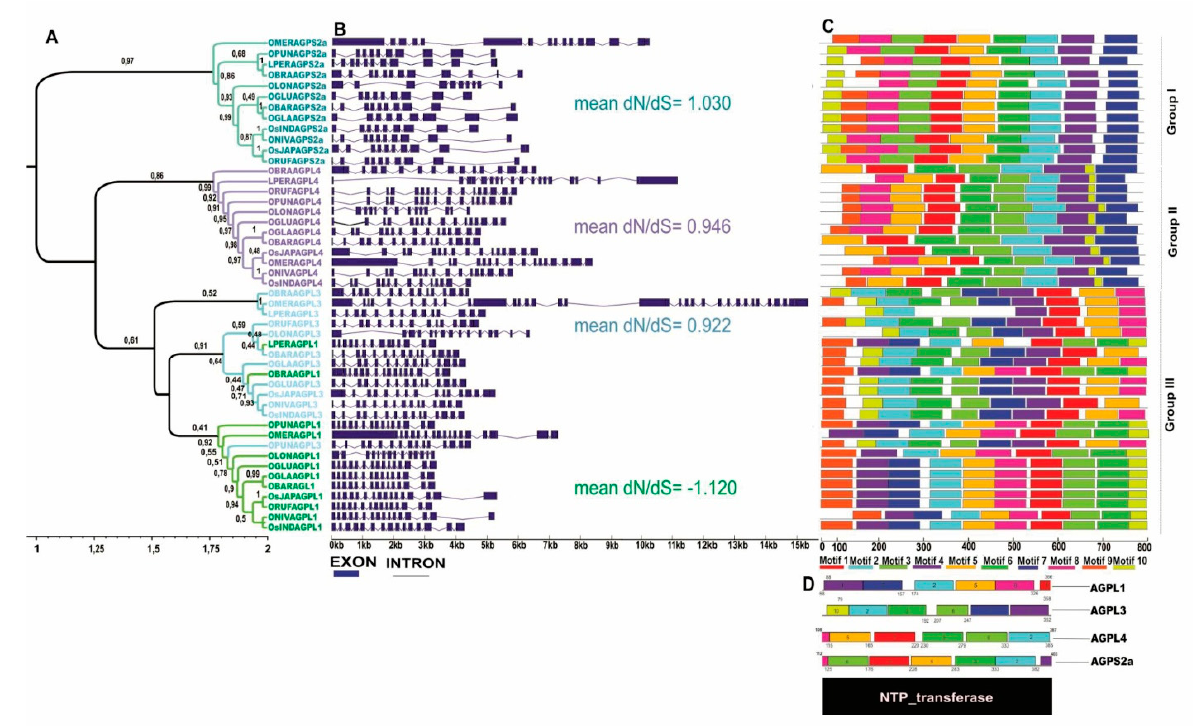
Figure 2. Phylogenetic relationship, genetic structure and analysis of conserved motifs in AGPase genes of species of the genus Oryza . ( A ) Phylogenetic protein tree. The branches of the AGPS2a, AGPL4, AGPL3 and AGPL1 proteins are marked in dark green, purple, light blue and light green, respectively. The bootstrap values are indicated in the phylogenetic tree. ( B ) Exon ‐ intron structure of the AGPase genes in Oryza . ( C ) Protein motifs indicated in different colors. ( D ) Protein domain shared by AGPase proteins.